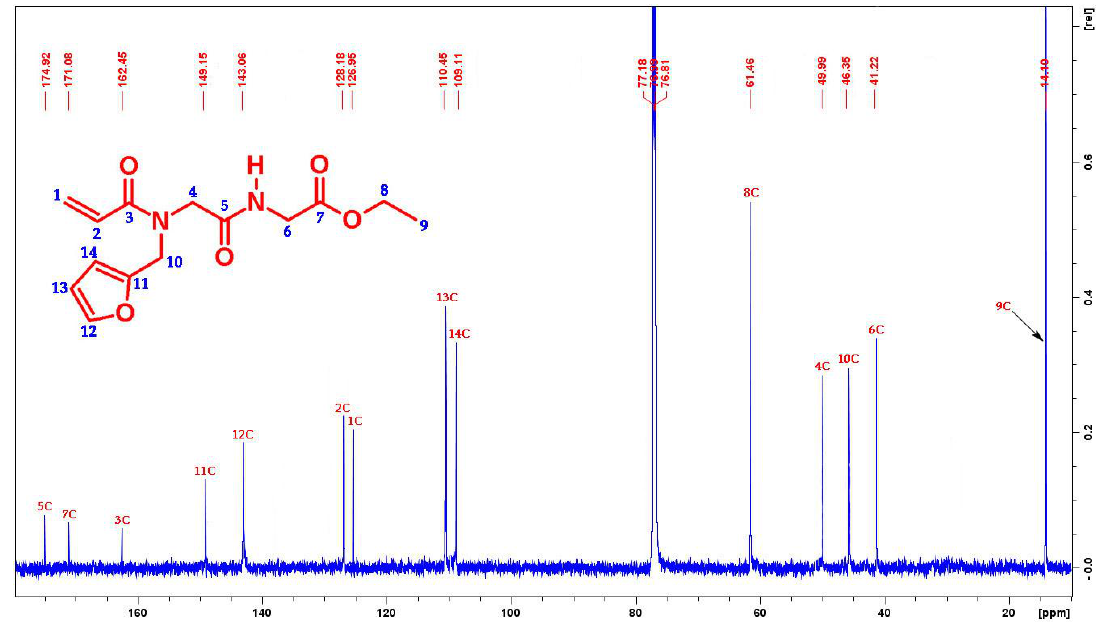
Figure 2. 13 C-NMR spectra of the desired compound (176 MHz, CDCl 3 ) at room temperature.